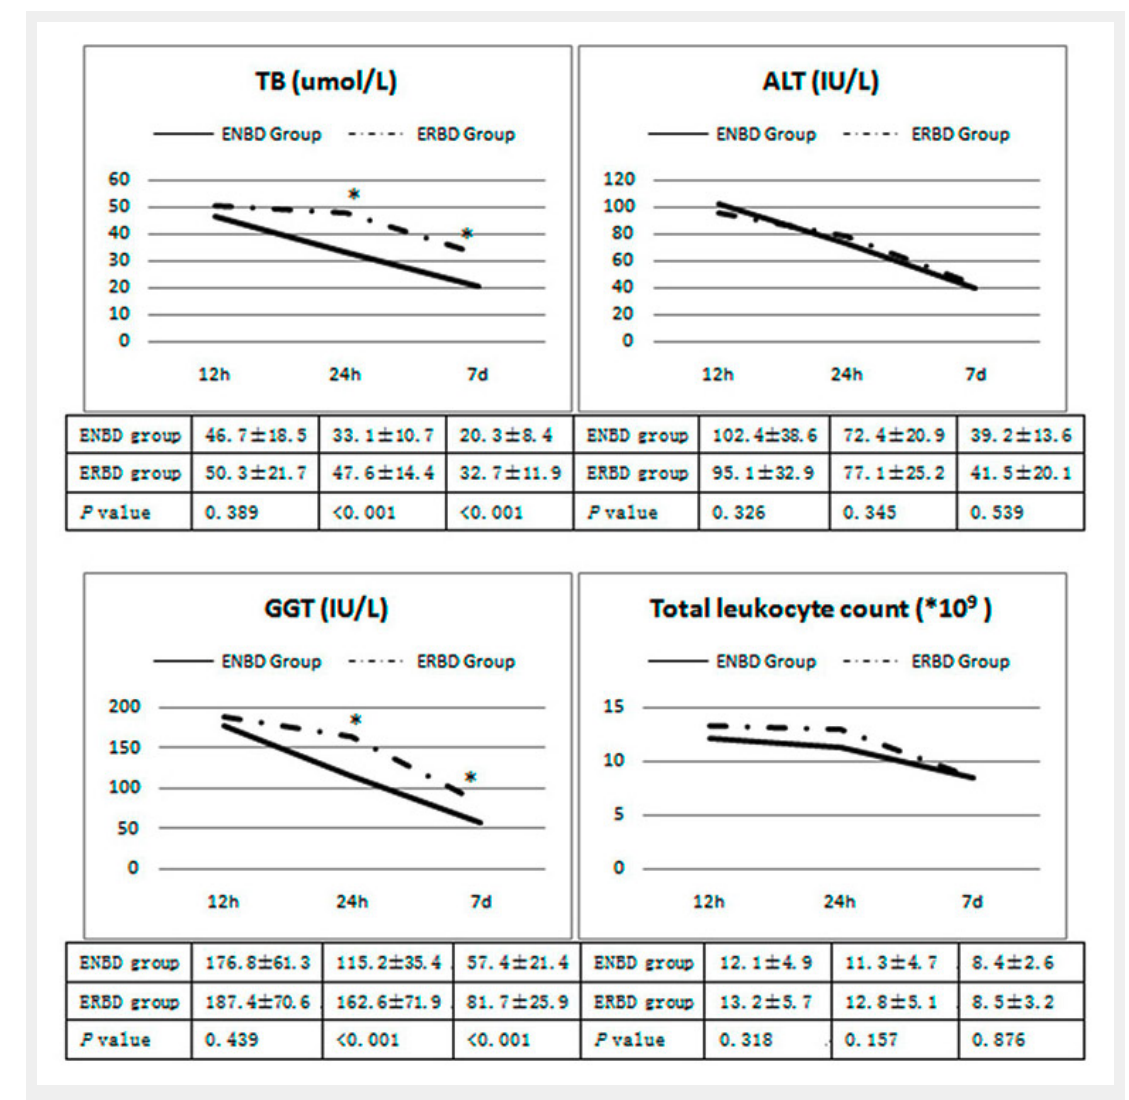
Figure 2 Total bilirubin (TB), alanine aminotransferase (ALT) and gamma-glutamyl transferase (GGT) concentrations and total leucocyte count 12 hours, 24 hours and 7 days after endoscopic retrograde cholangiopancreatography in the endoscopic nasobiliary drainage (ENBD) and endoscopic retrobiliary drainage (ERBD) groups. * p <0.05 vs ENBD